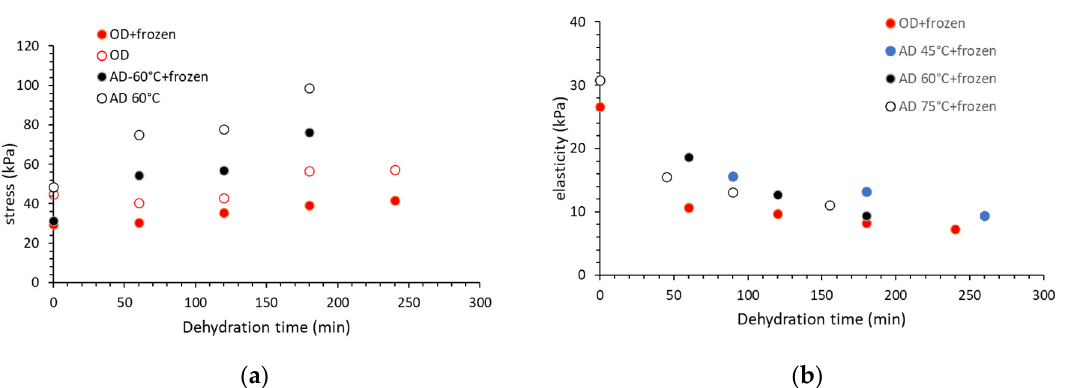
Figure 3. Mechanical properties change during dehydration of pineapple slices, expressed by ( a ) stress increase during osmotic dehydration at 45 °C–60° Brix and air drying (AD) at 60 °C prior to freezing and after the freezing/thawing process and ( b ) elasticity decrease during osmotic dehydration at 45 °C–60°Brix and air drying (AD) at 45, 60, and 75 °C after the freezing/thawing process (data adopted from [28]).